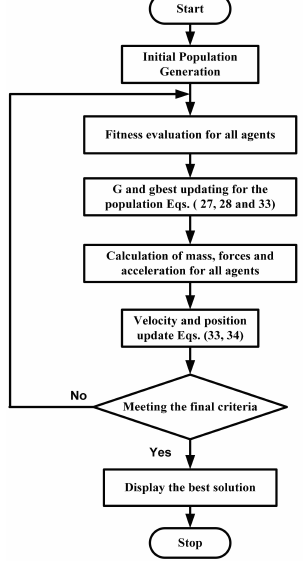
Figure 7. Flow chart of PSOGSA